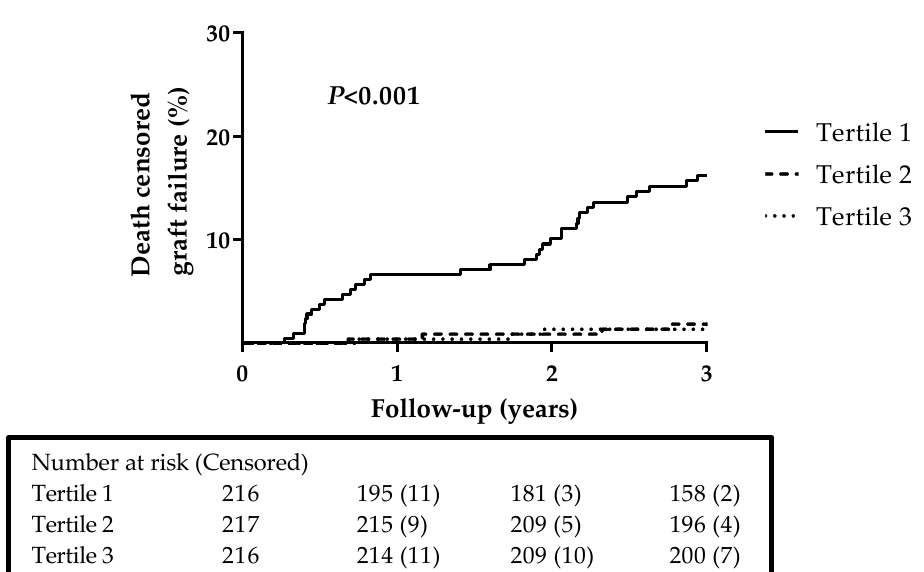
Figure 2. Kaplan–Meier curves by tertiles of uEGF / Cr on graft failure. Tertile 1: < 4.78 ng / mg; Tertile 2: 4.78–8.80 ng / mg; Tertile 3: > 8.80 ng / mg. P value was obtained from the log-rank (Mantel cox) test. uEGF / Cr, urinary epidermal growth factor / creatinine ratio.